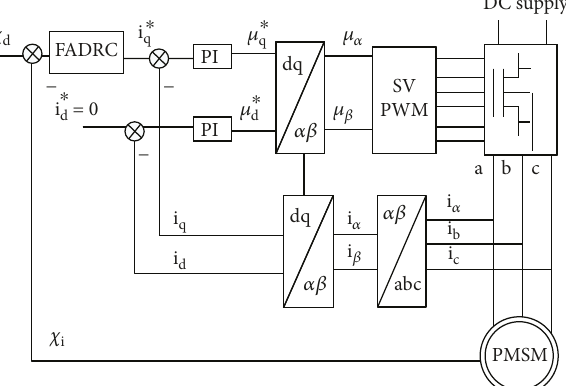
Figure 1: The control schematic diagram of each PMSM.